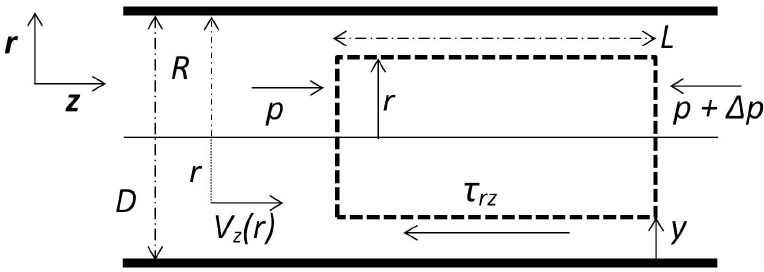
Figure 1. A schematic of a circular horizontal pipe